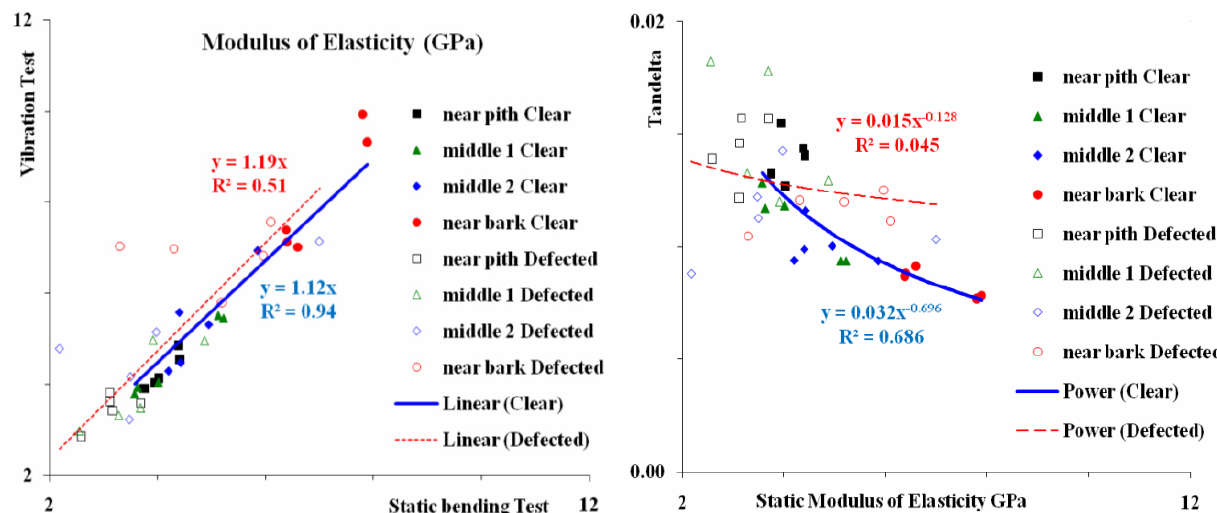
Fig. 5. Modulus of elasticity in static and dynamic method for knot-containing and knot-free specimens from pith to bark